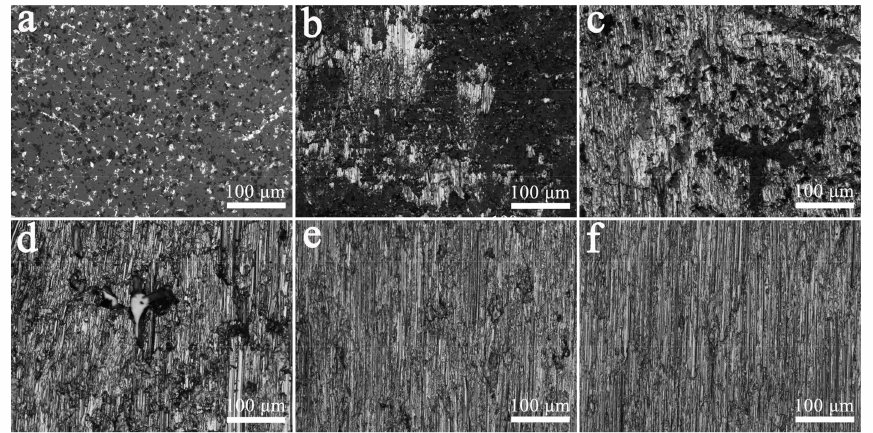
Figure 8. Optical microscope images of the joints fracture morphologies of the two kinds of sample brazed at different temperatures. Without Al film deposited sample: ( a ) 700 ◦ C; ( b ) 750 ◦ C; ( c ) 800 ◦ C; ( d ) 850 ◦ C; ( e ) 900 ◦ C; with Al film deposited: ( f ) 700 ◦